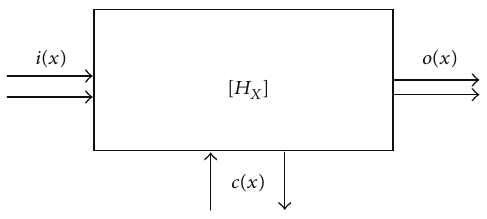
Figure 1: A general substructure representation.